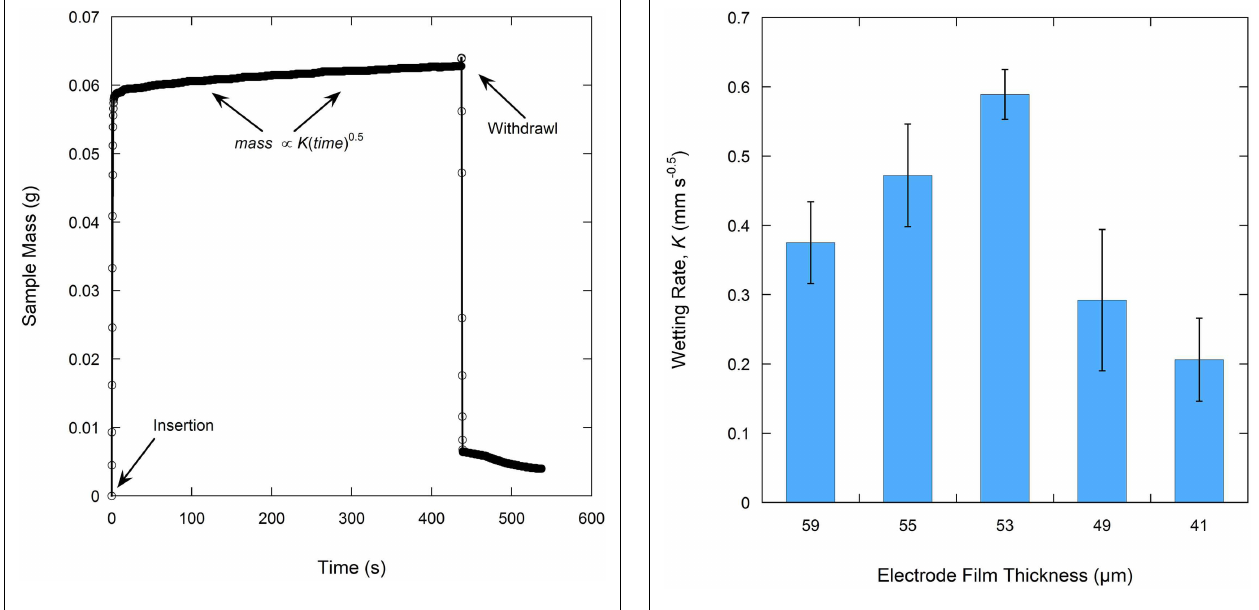
FIGURE 2 |Wetting rate for electrode films calendering under various pressure .